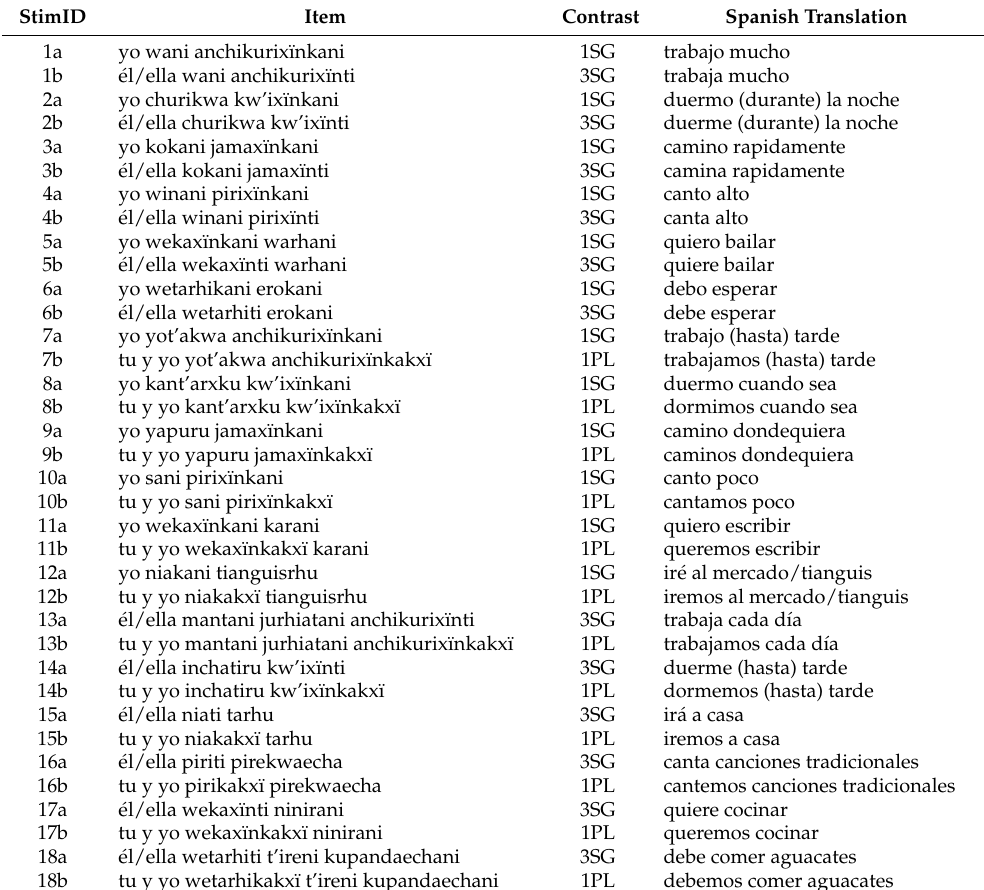
Table A1. Experimental stimuli: Spanish to P’urhepecha switches.